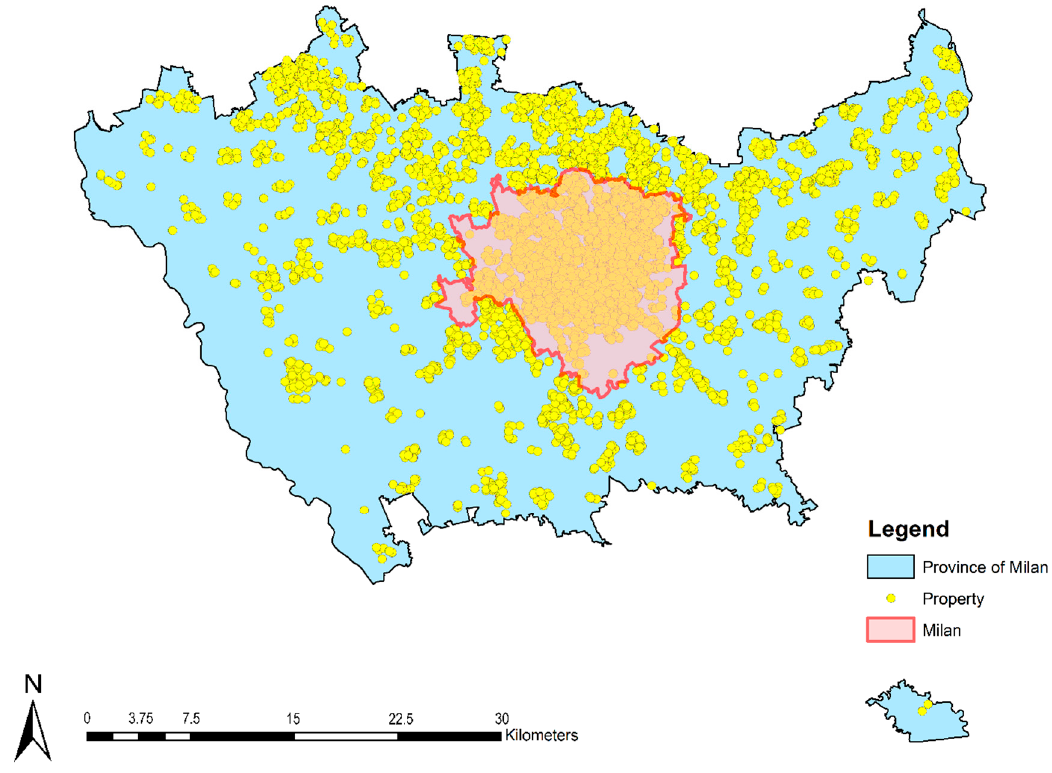
Figure 2. Spatial distribution of properties in the city of Milan and across the province.